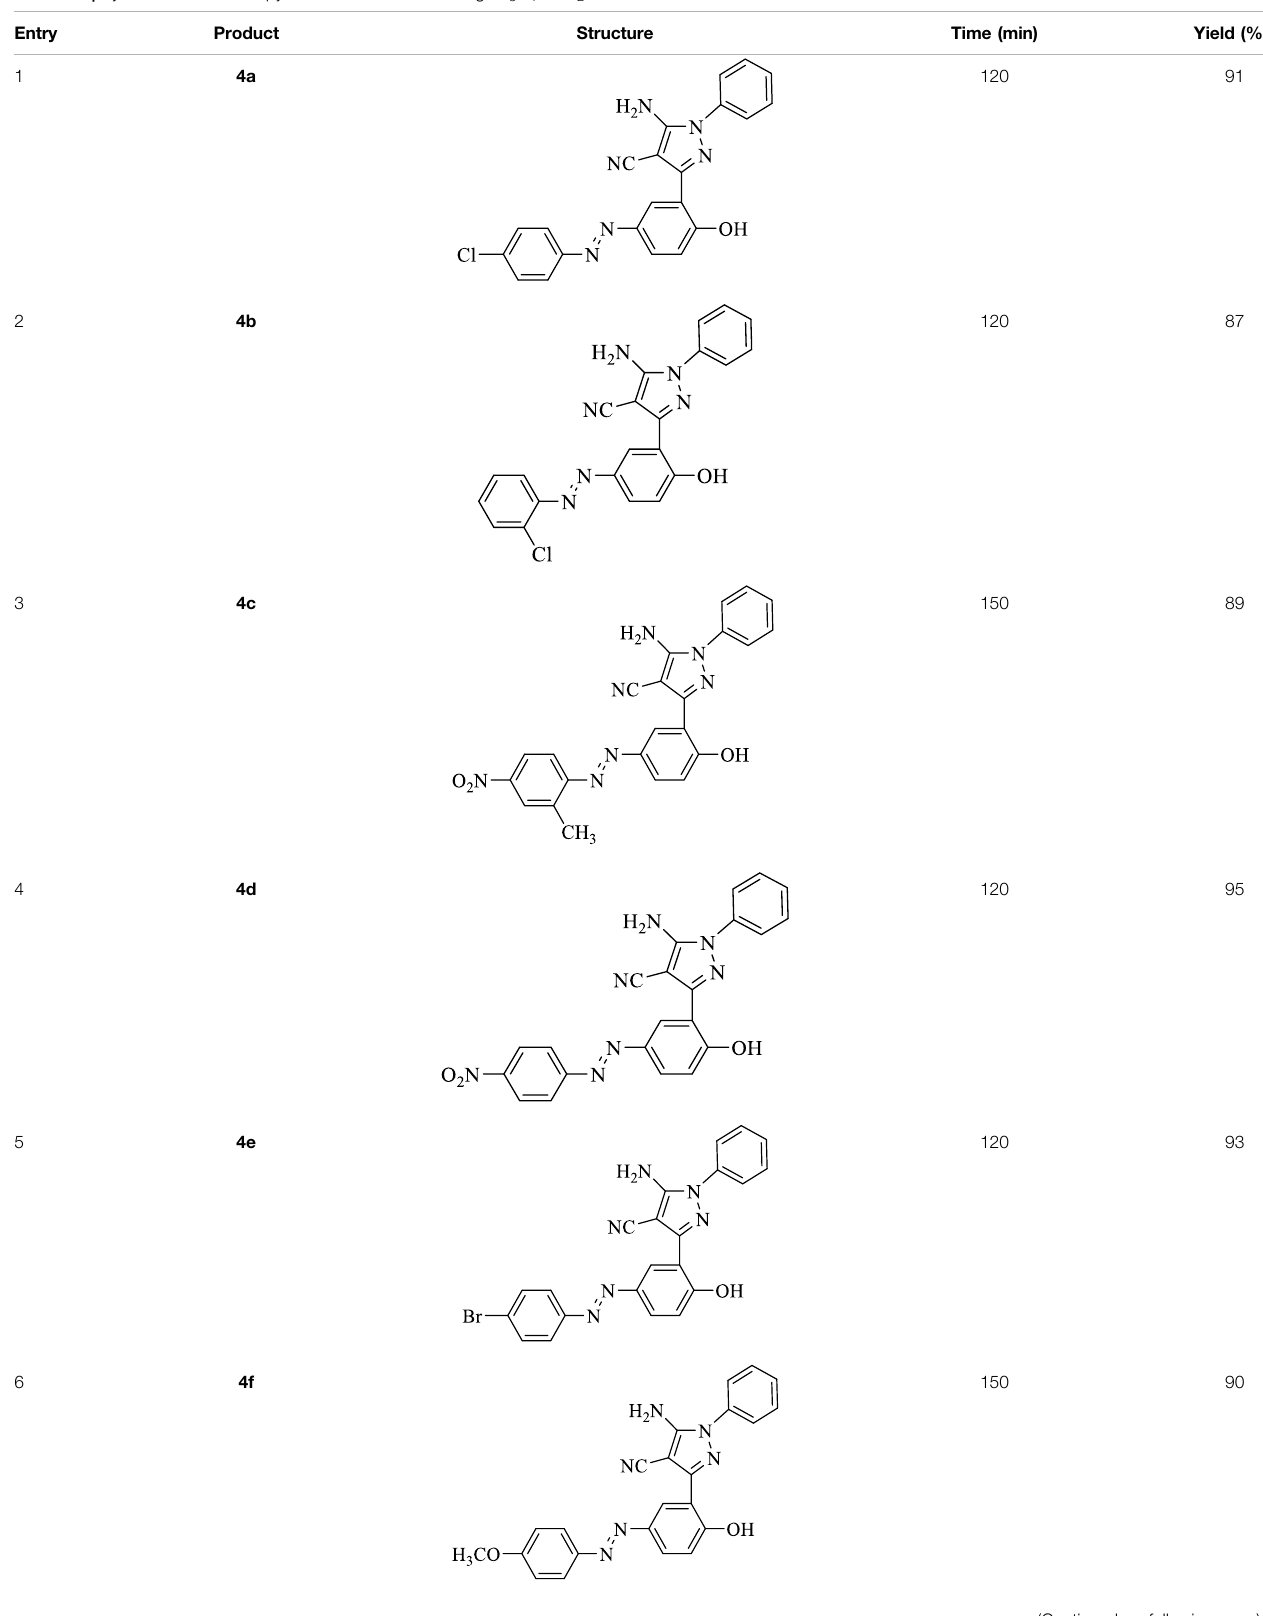
TABLE 3 | Synthesis of 5-amino-pyrazole-4-carbonitriles using Fe 3 O 4 @SiO 2 @Tannic